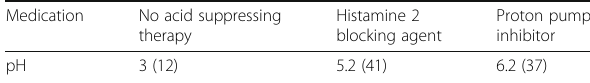
Table 81 (abstract A253). Gastric pH with acid suppressing therapy, mean